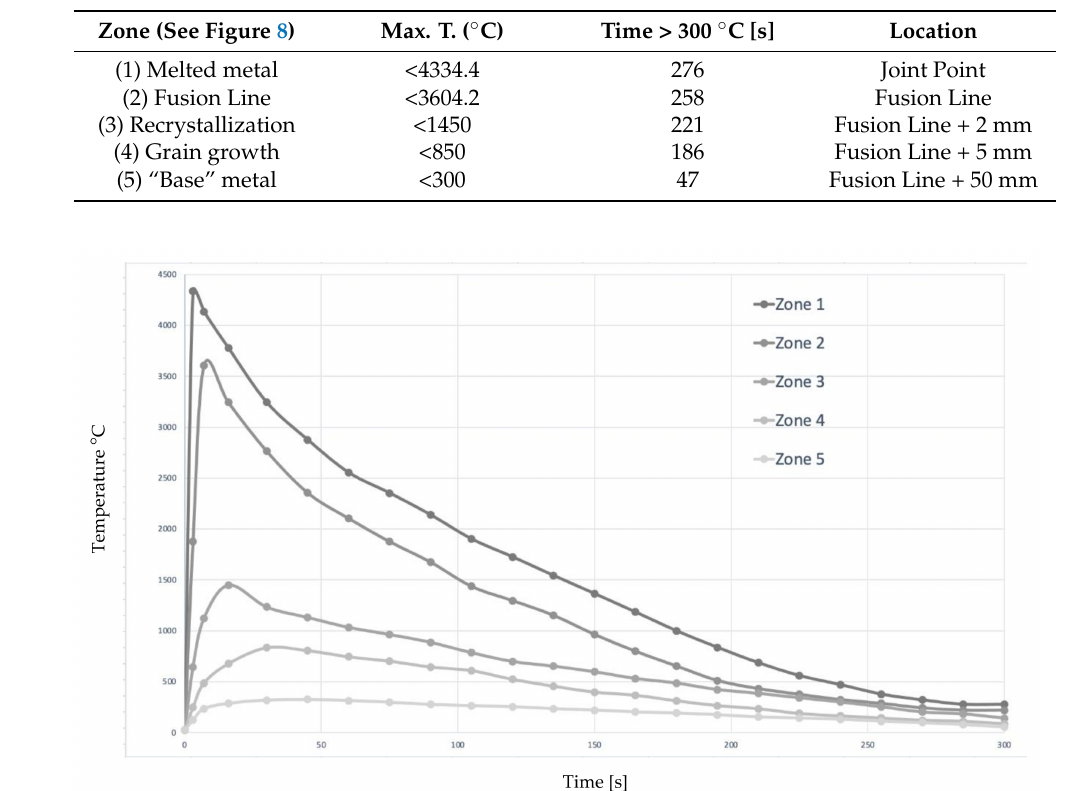
Figure 10. Cooling cycle after welding for the five zones referred to in Table